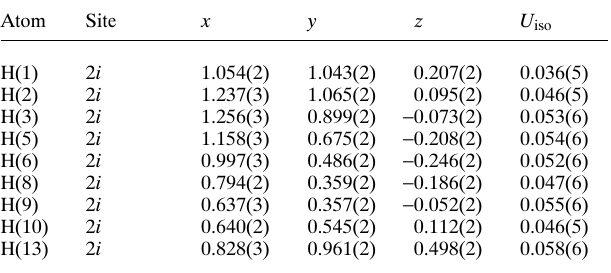
Table 2. Atomic coordinates and displacement parameters (in Å 2 )